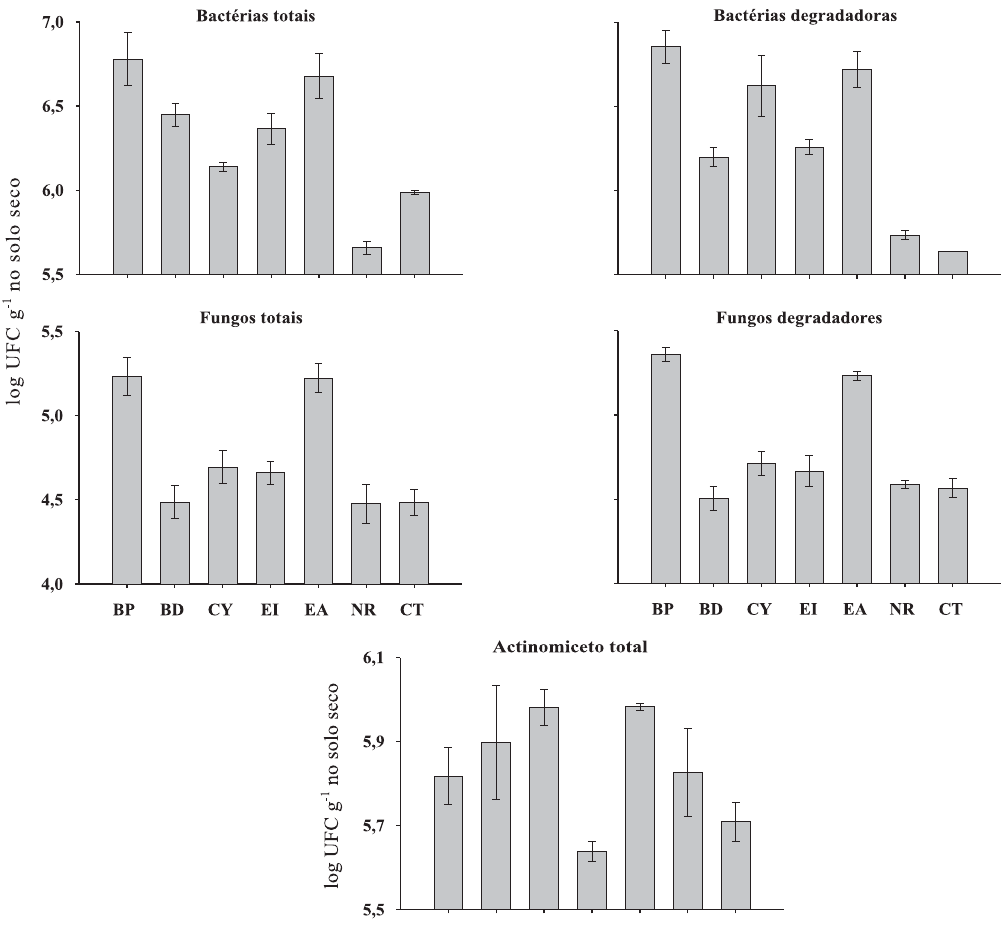
Figura 1. Contagem de células viáveis de microrganismos totais e degradadores de antraceno em solos rizosféricos de plantas de crescimento espontâneo em área de “landfarming” de resíduos petroquímicos. BP ( Bidens pilosa ), BD ( Brachiaria decumbens ), CY ( Cyperus sp.), EI ( Eleusine indica ), EA ( Eclipta alba ), NR (Solo não-rizosférico) e CT (Solo- controle sem planta). Linhas verticais indicam o erro- padrão da média (n =